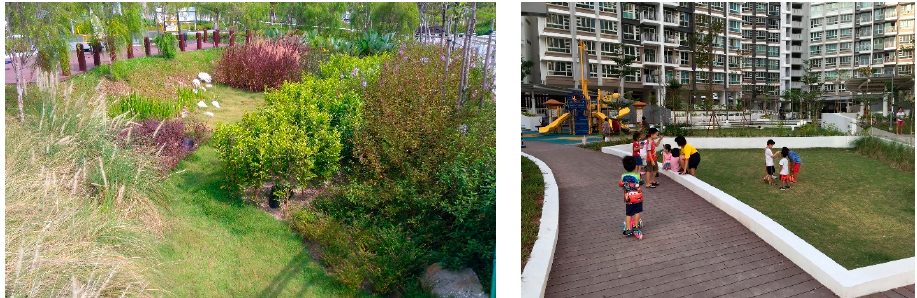
Figure 4. Photos of bioretention lawns in Waterway Ridges.